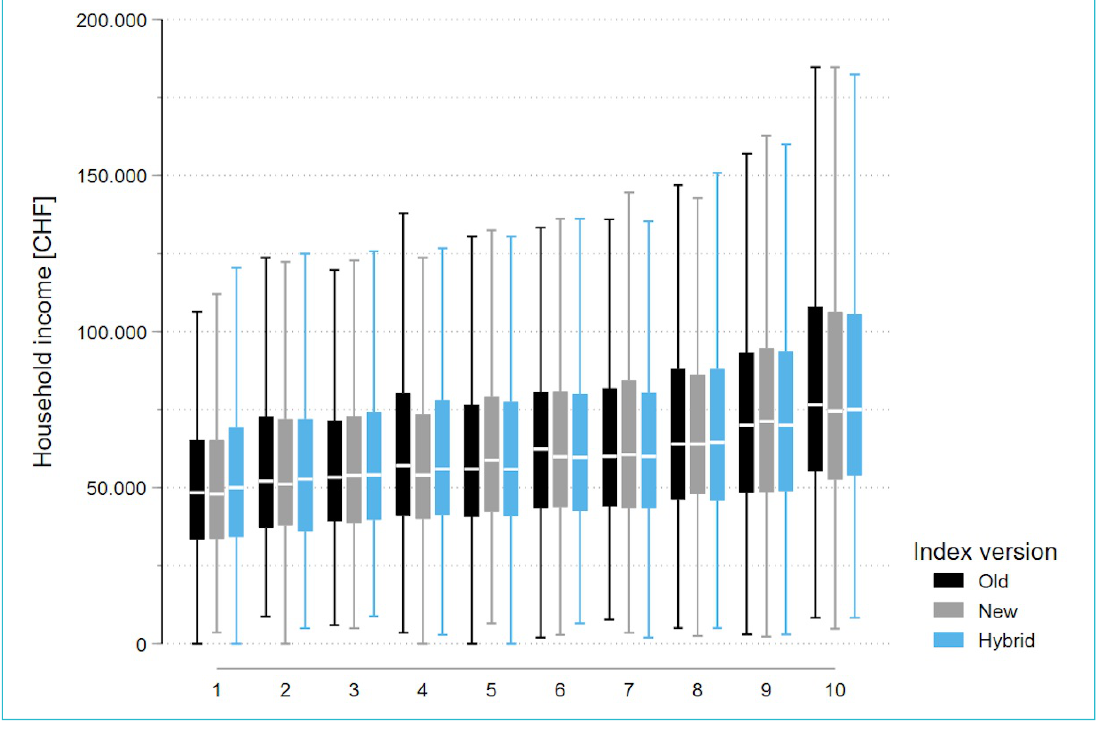
Figure 2: Box plots of the distribution of equivalised yearly household income across the deciles of three indices. Data from 7,193 Swiss Household Panel participants who provided information or had imputed information on the income questions in 2014. Boxplots exclude outliers for better visibility of the central distribution. See online appendix for more details.